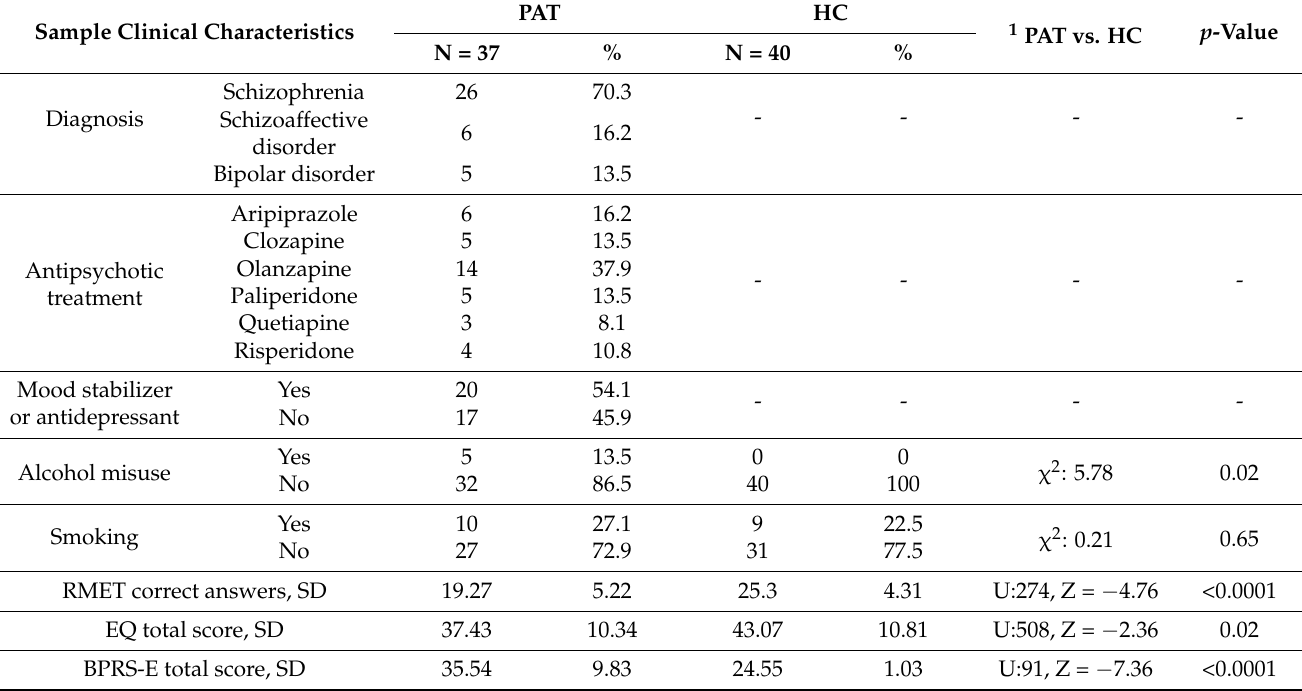
Table 2. Sample clinical